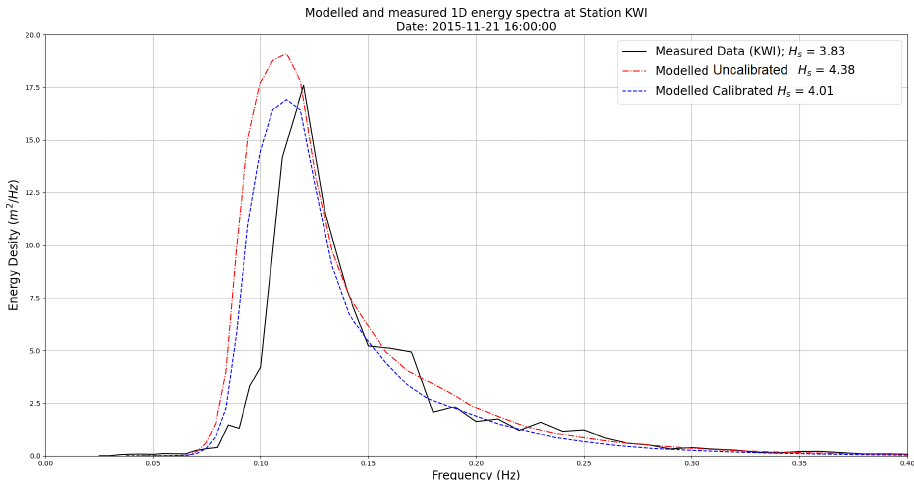
Figure 9. Spectral comparison for the Kwintebank station on 21 November 2015 16:00 showing the uncalibrated and calibrated SWAN models forced with ECMWF-ERA5.